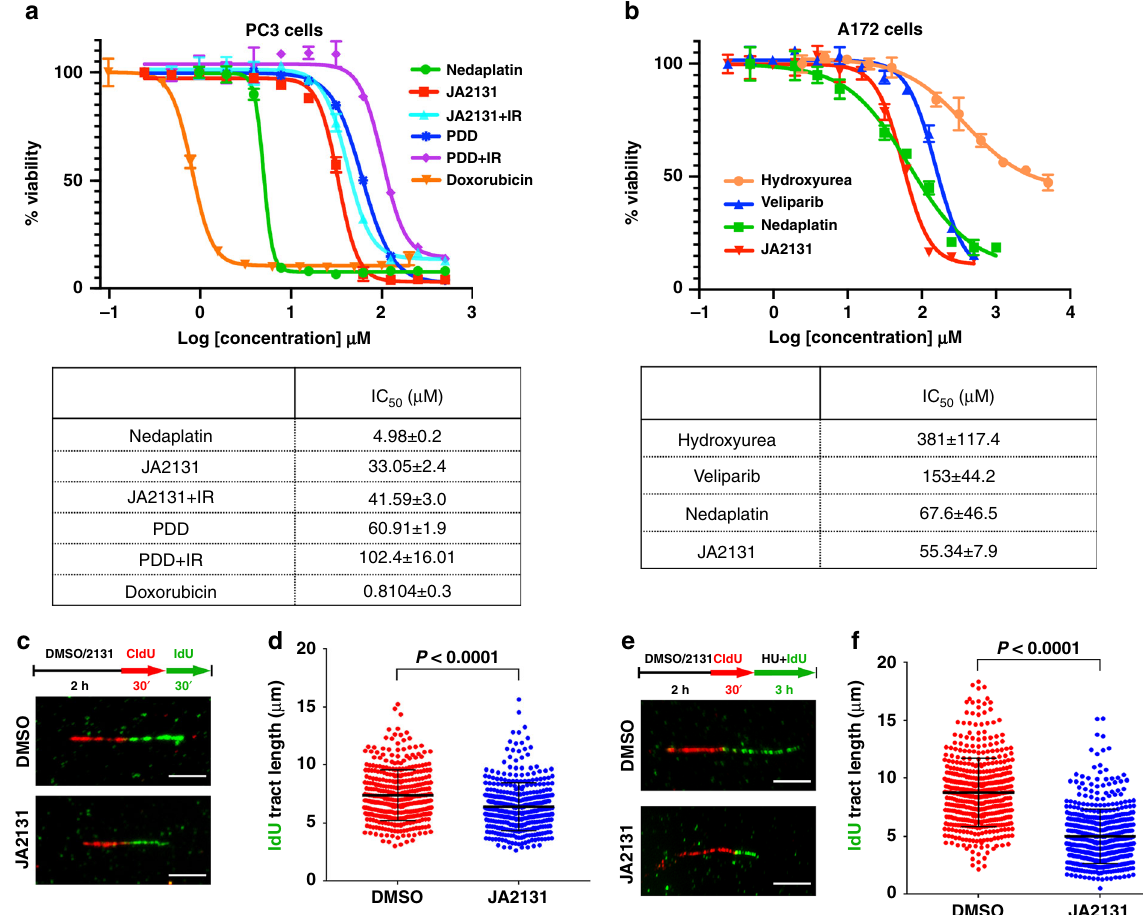
Fig. 7 Cytotoxicity and fork stalling induced by PARGi. a Cytotoxicity of PC3 cells for the indicated compounds with or without 7 Gy IR for 72 h treatment periods. Normalized % viabilities are plotted against log concentration. Error bars show the percent coef fi cient of variation. The data table shows IC 50 values for each compound. b Comparisons of the relative cytotoxicity of JA2131 against the designated DNA damaging agents for A172 glioblastoma cells. Treatment period 72 h. c A schematic of the dual-labeling regime used for the replication fork progression DNA fi ber assay and representative DNA fi ber images of the replication tract from DMSO and JA2131 treated HeLa cells. Scale bar 5 μ m. d Quanti fi cation of the IdU tract analysis for more than 380 replication forks. e Schematic representation of HU (0.4 μ M) treatment for fork progression analysis and the representative DNA fi ber image of replication tracts of DMSO and JA2131 treated HeLa cells. Scale bar 5 μ m. f Quanti fi cation of the IdU track of more than 470 replication forks for each data group. Mann-Whitney test was used to generate the p -value. The DNA spread assay is the representation of two independently repeated experiments. Source Data are provided as a Source Data fi